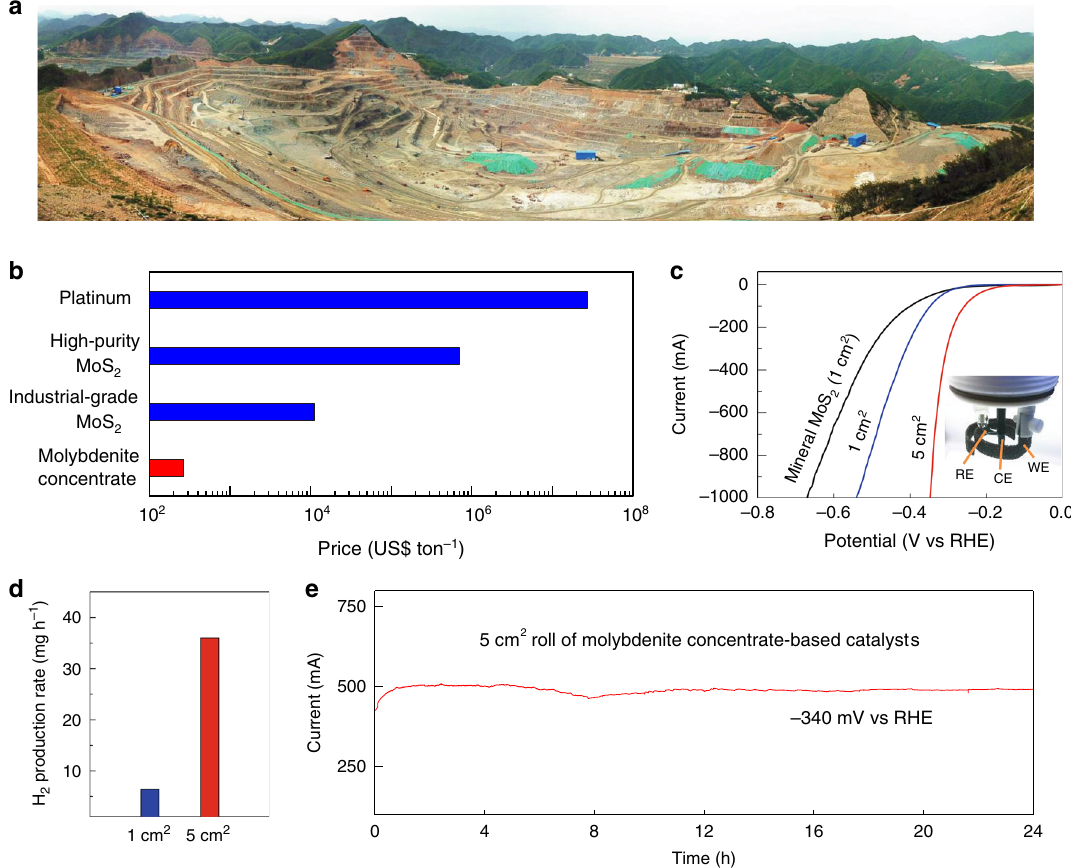
Fig. 4 MoS 2 mineral catalysts from cheap molybdenite concentrates for high-current-density HER. a Bird ’ s eye view of the Sandaozhuang open-pit molybdenite mine in Luoyang, China. Reproduced from Ref. 28 . The length of the fi eld is around 1.5 km. b Commodity price differences between platinum, high-purity MoS 2 , industrial-grade MoS 2 , and molybdenite concentrate. c Polarization curves of the different catalysts in 0.5 M H 2 SO 4 at a scan rate of 5 mV s − 1 with iR correction. Inset is an optical image of a three-electrode electrolyzer for larger working electrodes. d H 2 production rate of different molybdenite concentrate-based catalysts to produce hydrogen under − 390 mV vs RHE without iR correction. e Chronoamperometric response ( i – t ) curve of a 5 cm 2 roll of cheap mineral-based catalyst for HER at current of ~500 mA over 24